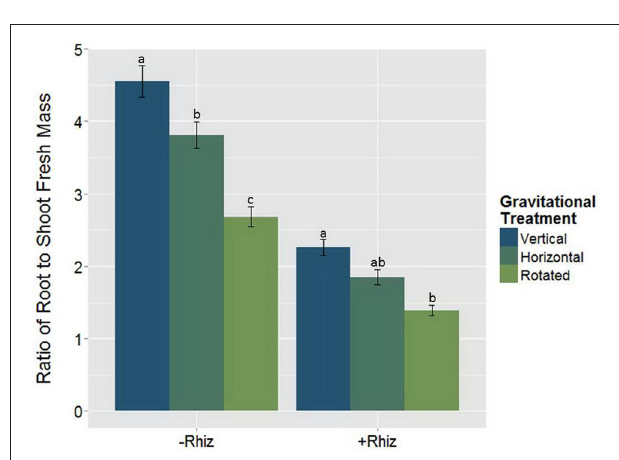
with rhizobia only, and 47.5 ± 6.7 ( N = 10) for those inoculated